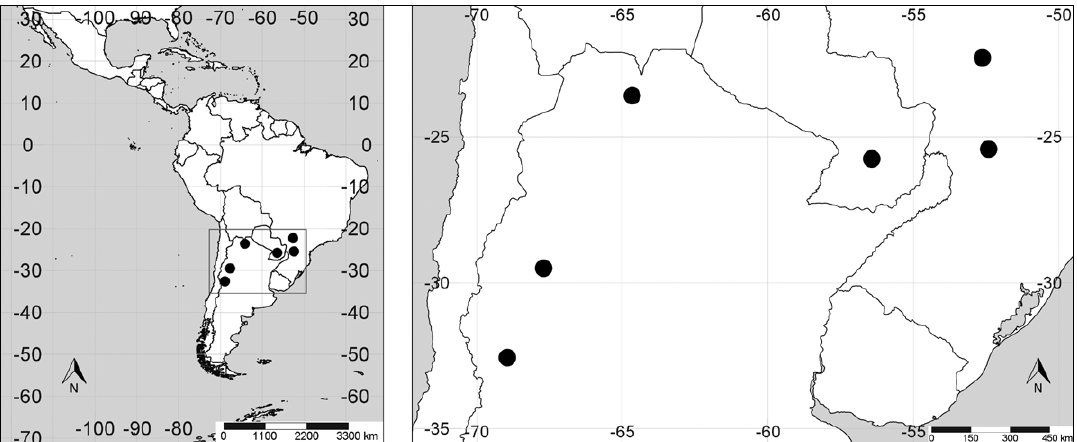
Figure 1. Records of Nausigaster flukei in Brazil, Paraguay and